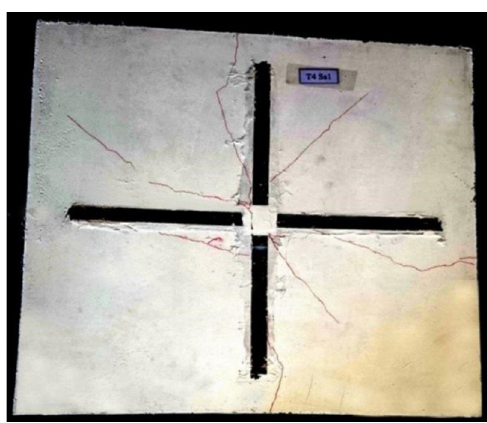
Figure 10: Crack pattern of the slab T4R under impact loading.